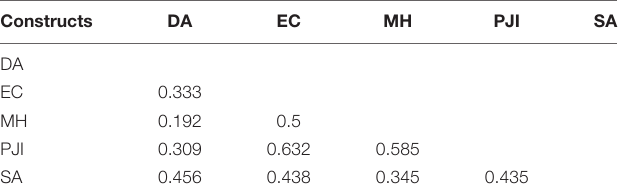
TABLE 4 | Heterotrait-Monotrait